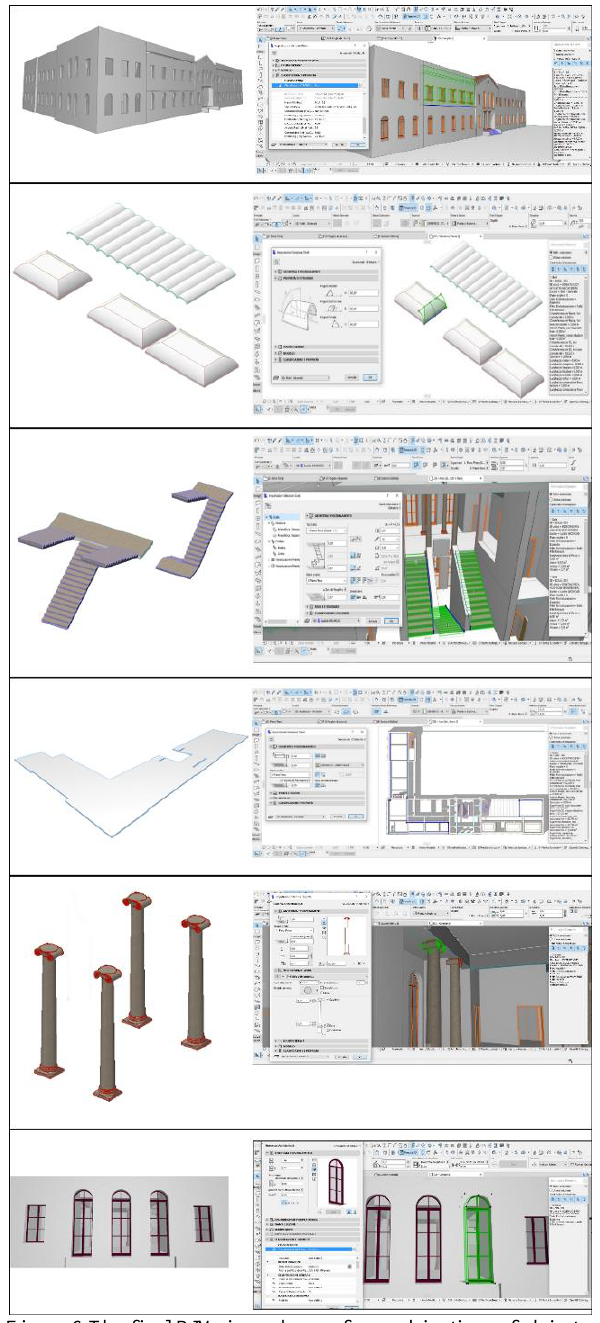
Figure 6 The final BIM is made up of a combinations of objects with variable geometric complexity.